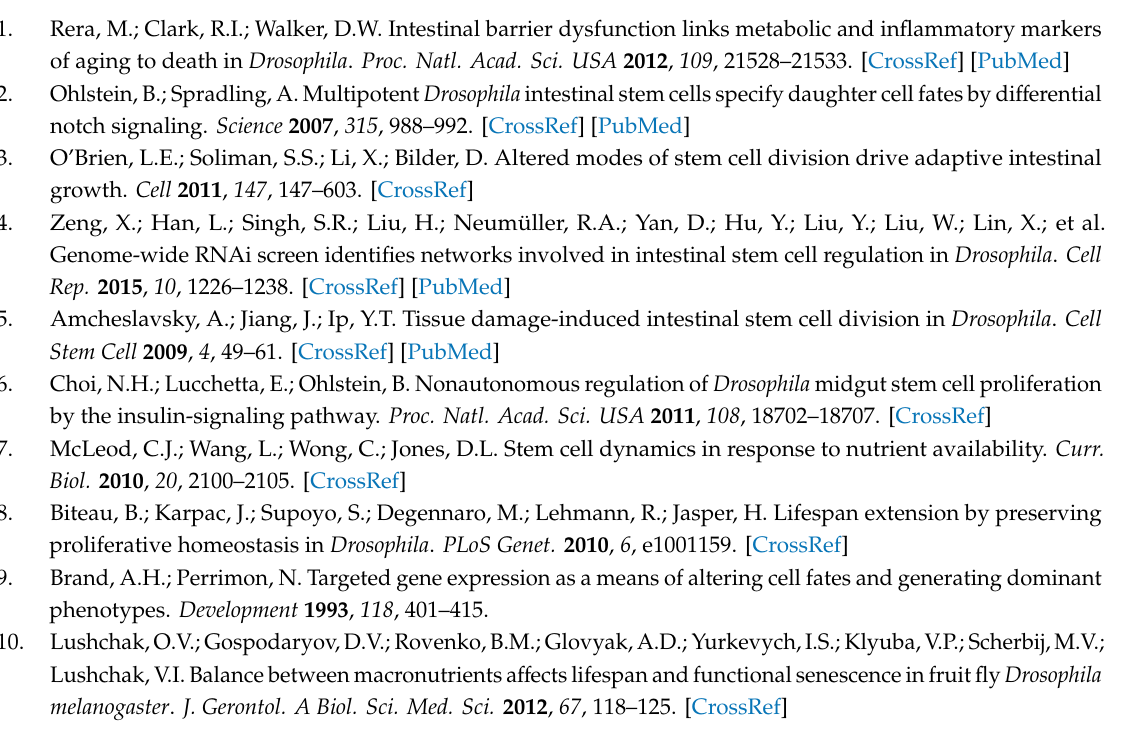
Figure S1: Relative InR and Pten expression in flies with IIS inhibition / activation in whole Drosophila body, Figure S2: Amount of TAG of flies with IIS modulated in stem and progenitor cells, Figure S3: Number of “smurf” flies, an indicator of gut integrity, in control, InR-RNAi - and Pten-RNAi- expressing flies, Table S1: Statistical analysis of lifespan and stress resistance of the experimental flies with inhibited / activated IIS in ISCs and EBs, Table S2: Primer pairs used for